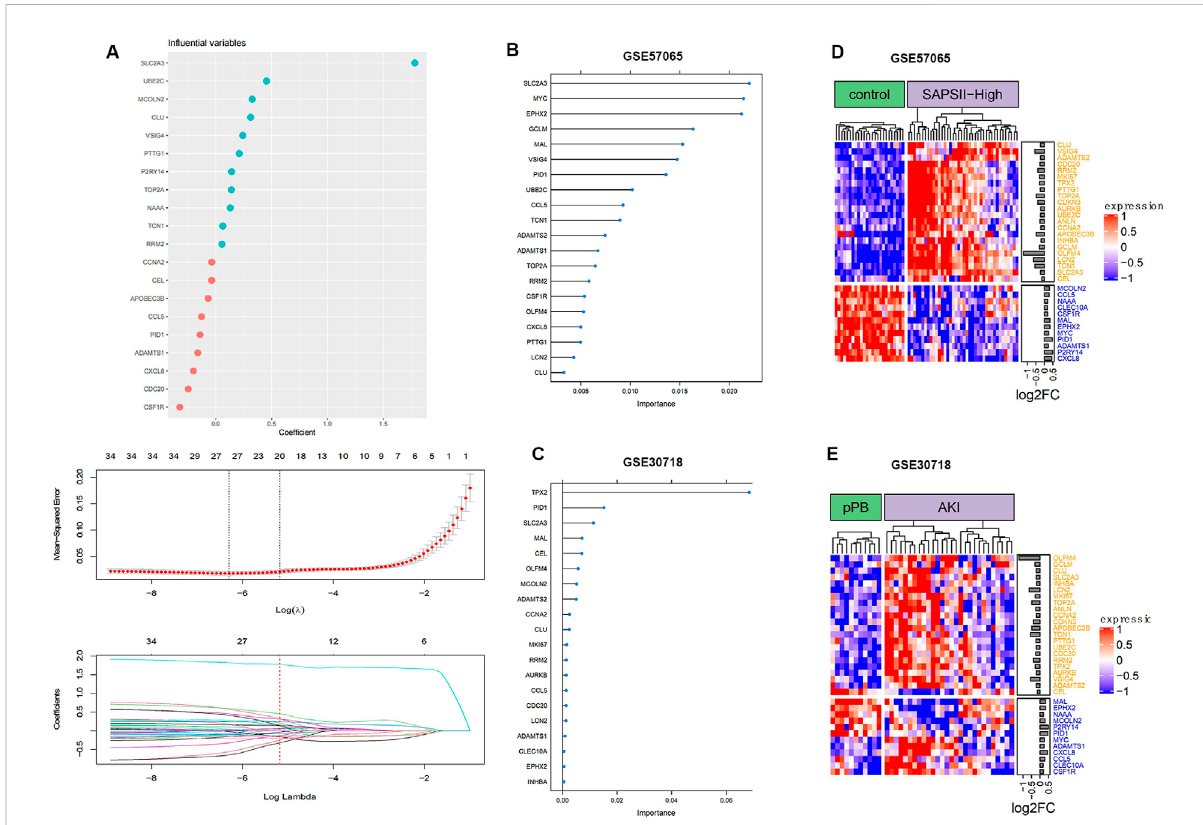
FIGURE 6 Ferroptosis gene expression distribution. (A) Process of feature selection in training sets; top-20 signi fi cant DEGs were screened by random forestandlassoregressionanalyses. (B) ClusteringofferroptosisgenesinGSE57065. (C) ClusteringofferroptosisgenesinGSE30718. (D) Importance distribution of ferroptosis signature genes in GSE57065. (E) Importance distribution of ferroptosis signature genes in